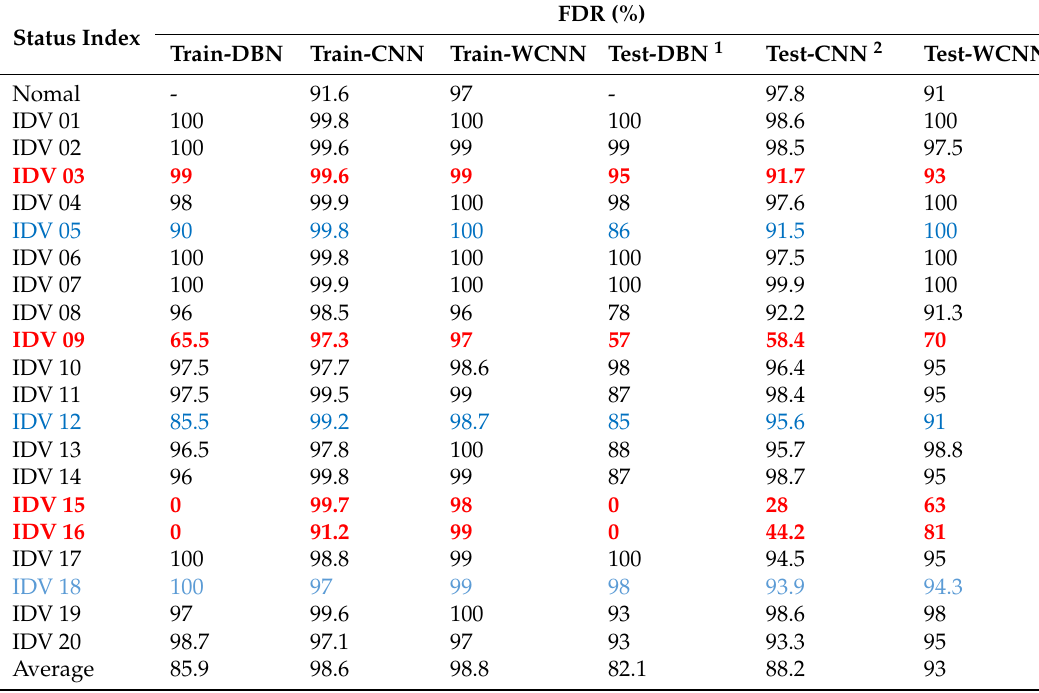
Table 6. The monitoring performance of the TE process obtained by DBN, CNN and